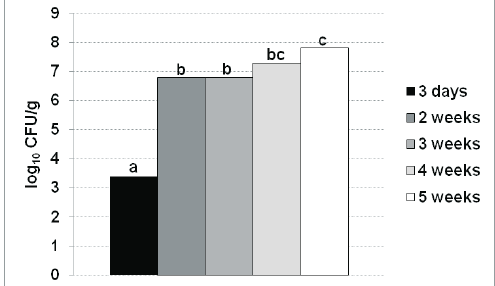
Fig. 1. Microbiological quality (log bic microorganisms) in reindeer samples ( M. longis- simus dorsi , n =6 for each treatment) stored in vac- uum bags at +4 °C for 3 days, 2, 3, 4 and 5 weeks post slaughter.Means with different letters are sig- nificantly different ( P ≤ (three days post slaughter) was 3.4 ± 0.3 log CFU/g (means and standard error; Fig. 1).